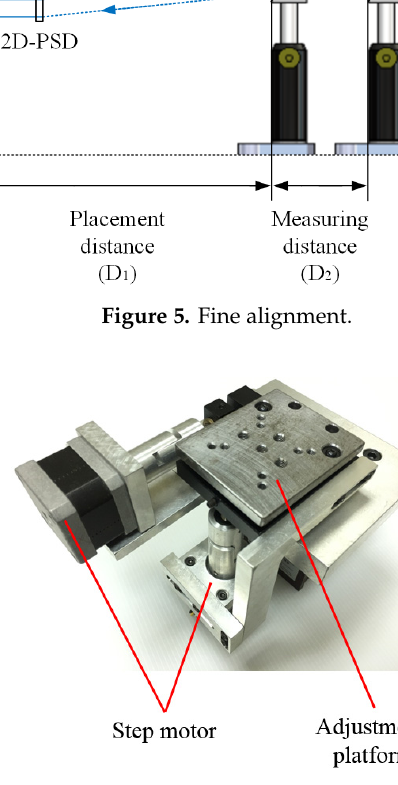
Figure 6. Mechanism design for auto-alignment.